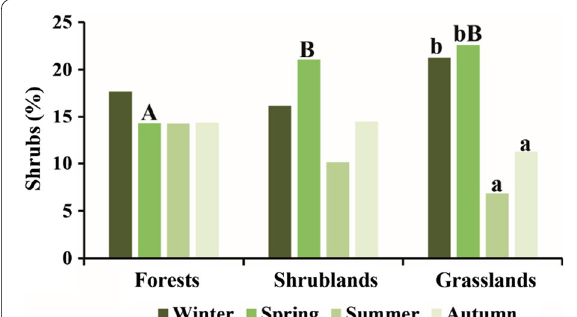
Fig. 3 Interactions corresponding to the life form of shrubs in Table 2. Tukey’s test revealed significant differences between letters at p < 0.05. For comparisons between vegetation types (forest, shrubland, grassland), lower case letters were utilized, whereas capital letters were used for comparisons between seasons (winter, spring, summer,